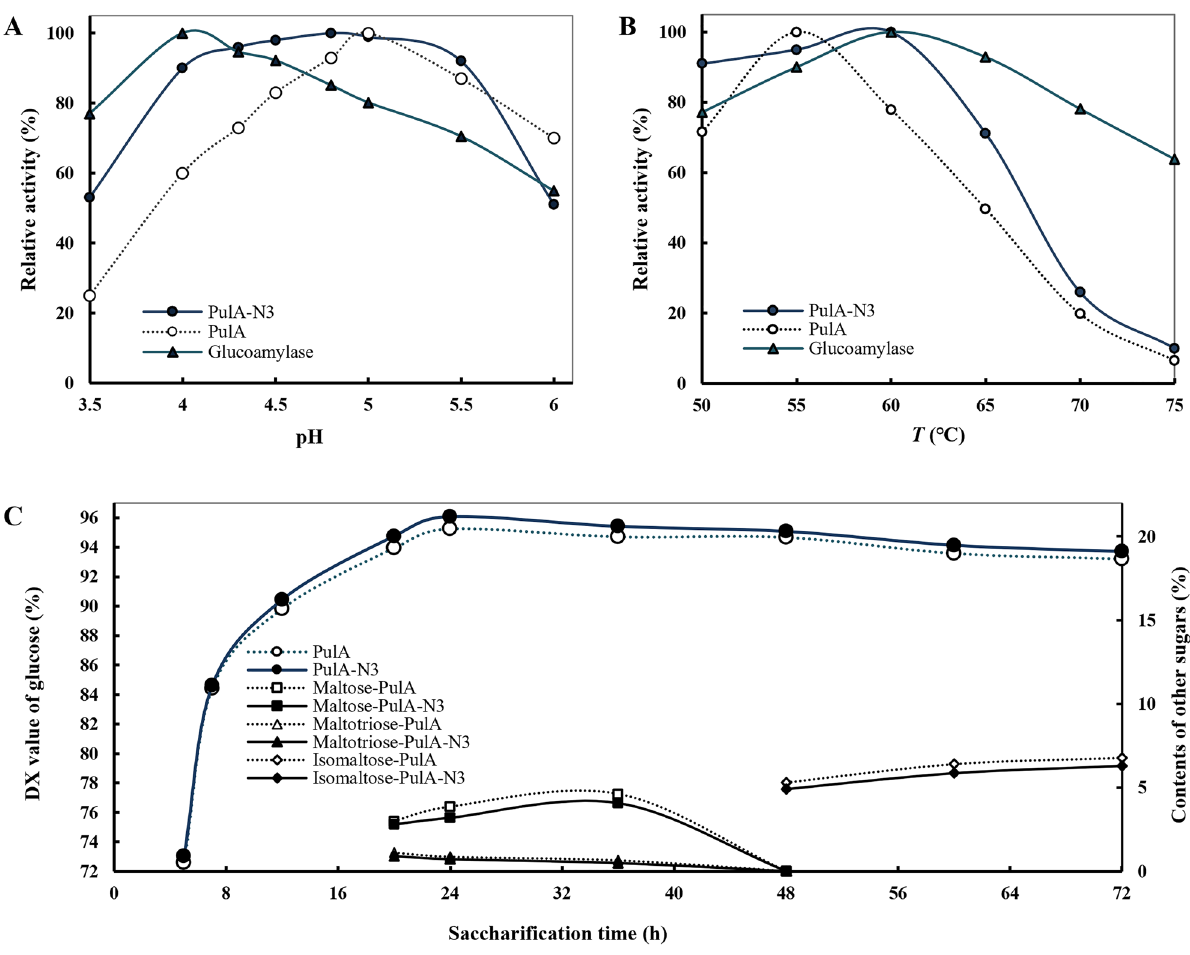
Figure 4. The time-course of corn starch saccharification with glucoamylase and PulA-N3. ( A ) Optimal pH for PulA-N3 and glucoamylase; ( B ) Optimal temperature for PulA-N3 and glucoamylase; ( C ) The time-course of corn starch saccharification. The saccharification experiments were carried out at 61 °C and pH 4.3 with 120 rpm stirring in 100-mL reaction vessels containing 30% (w/v) liquefied starch (DE value: 12) by adding 150 U/g (dried substrate) of glucoamylase and 1 U/g (dried substrate) of PulA-N3 or PulA. Samples were taken at certain time intervals and then boiled for 10 min to inactivate enzymes for measuring glucose content and the DX values (PulA and PulA-N3) were calculated to evaluate the degree of the saccharification by HPLC. The other sugars, including maltose (indicated as Maltose-PulA and Maltose-PulA-N3 in the figure), maltotriose (Maltotriose-PulA and Maltotriose-PulA-N3) and isomaltose (Isomaltose-PulA and Isomaltose-PulA-N3), were detected synchronously. The data were represented as average of triplicate